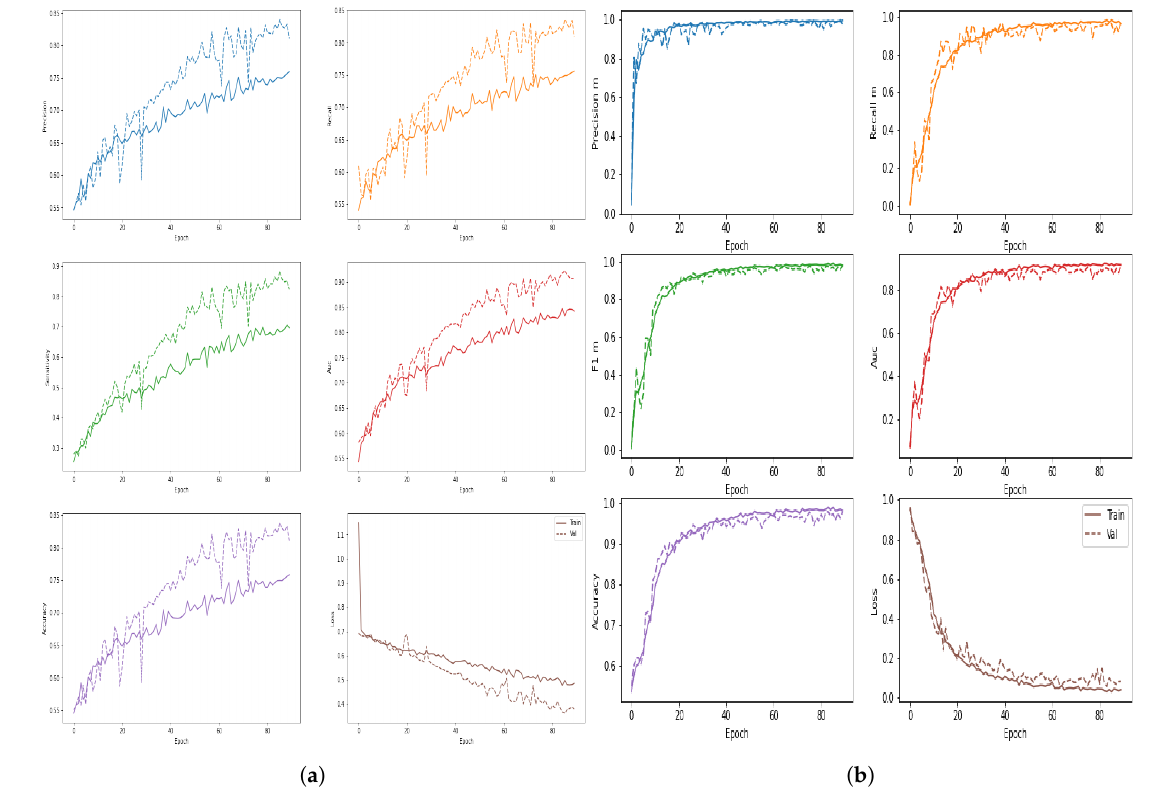
Figure 10. The figures represent the training and validation precision, recall, sensitivity, AUC, accuracy, and cross-entropy loss of ( a ) proposed ConvNet and ( b ) proposed